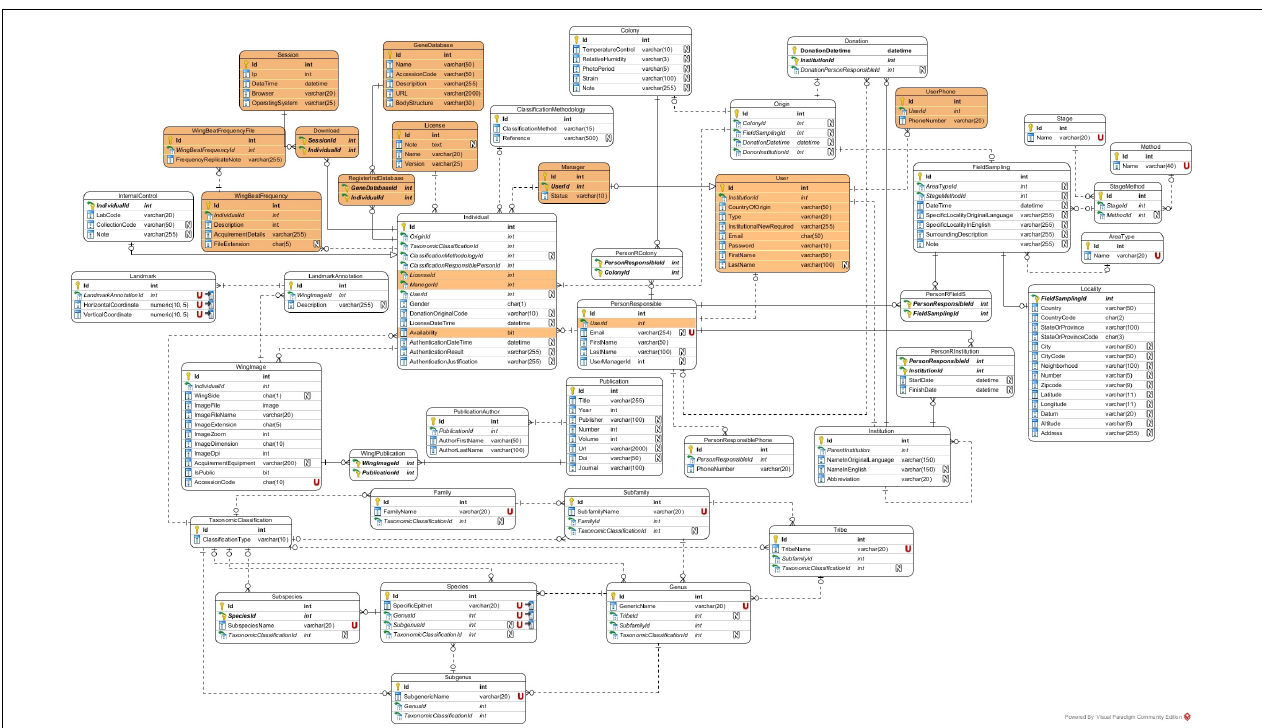
FIGURE 3 | Representation of the Logical Database Design by mapping a conceptual schema in the EER model into a relational representation. In this model, the types of entities are transformed into tables, the attributes in columns of the respective tables, the multivalued attributes in other tables, the relationships in foreign keys and (possibly) new tables. This diagram also shows the crow’s foot notation which indicates the cardinalities of the relationships established by means of foreign keys. Filled boxes: Entity, Attributes and Relationships which were planned but not yet implemented (Phase